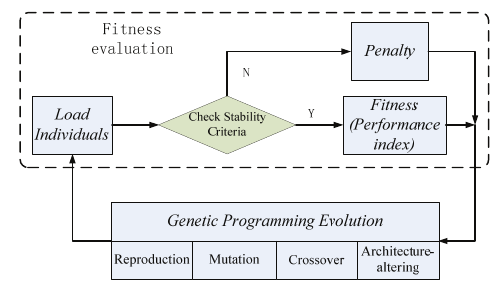
Fig.2. Block scheme of GP-based robust optimal controller